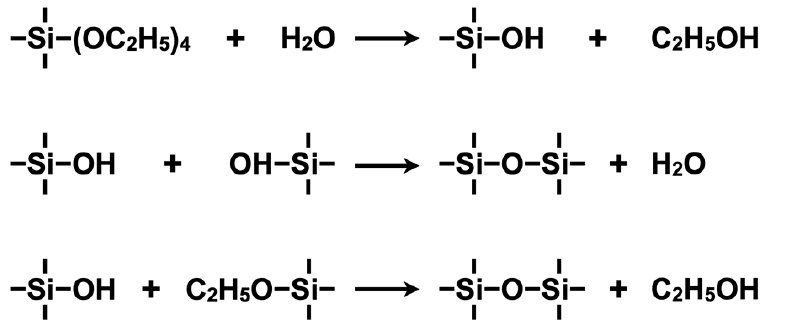
Figure 3. Key chemical reactions for the hydrolysis and polycondensation of tetraethyl orthosilicate (TEOS) under acidic or basic conditions. This is the central basic reaction in the sol ‐ gel method, from which many functional hybrids are prepared.